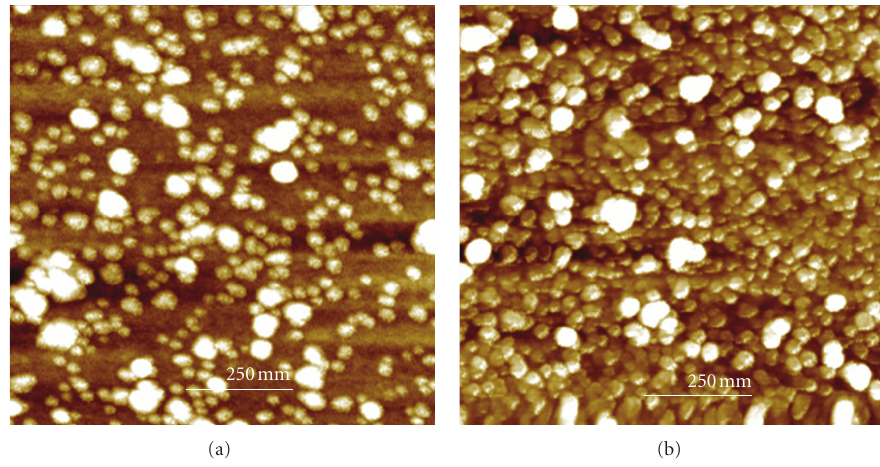
Figure 4: AFM images of (a) ferritin adsorbed without the TGA promoter (height scale = 30 nm) and (b) ferritin adsorbed in the presence of 0.05 mM TGA (height scale = 20nm). The TGA promoter results in greater, more uniform coverage of the surface with ferritin. Scale bar is 250 nm for both